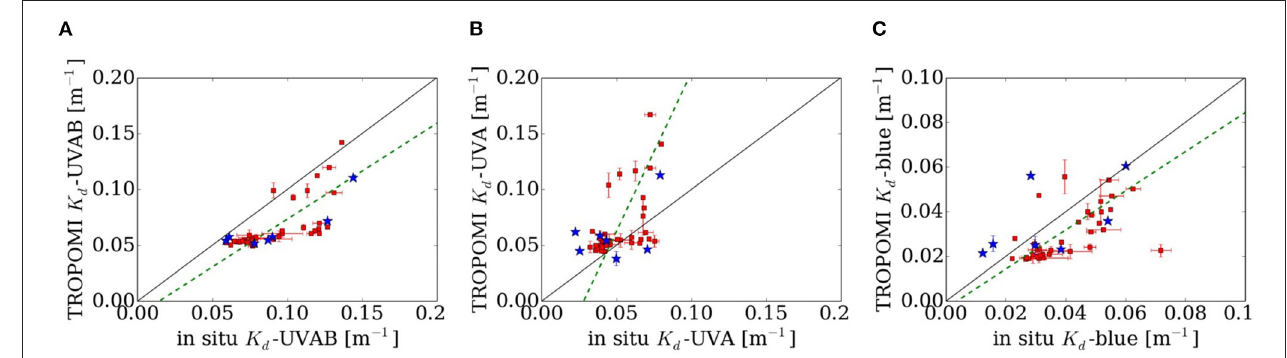
FIGURE 6 | TROPOMI (A) K d -UVAB, (B) K d -UVA, and (C) K d -blue against in-situ K d -UVAB, K d -UVA, and K d -blue. Match-ups between TROPOMI K d data and PS113 in-situ data were searched for within ± 2 days and 5.5km radius of the in-situ measurement. If more than one match-up was found within these search criteria, the mean TROPOMI and in situ K d were calculated with standard deviation shown as error bar.